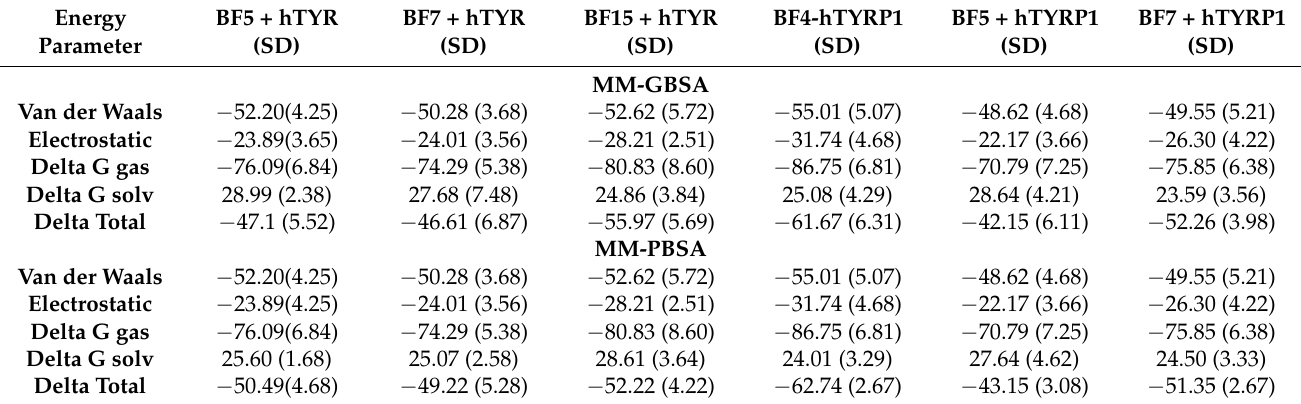
Table 4. Different energy contribution to net binding energy of